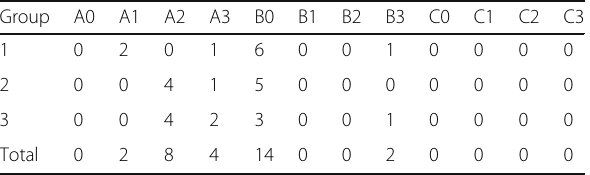
Table 4 Type of fractures according to the modified Müller AO Trauma Foundation Long bone Fracture classification (Reference